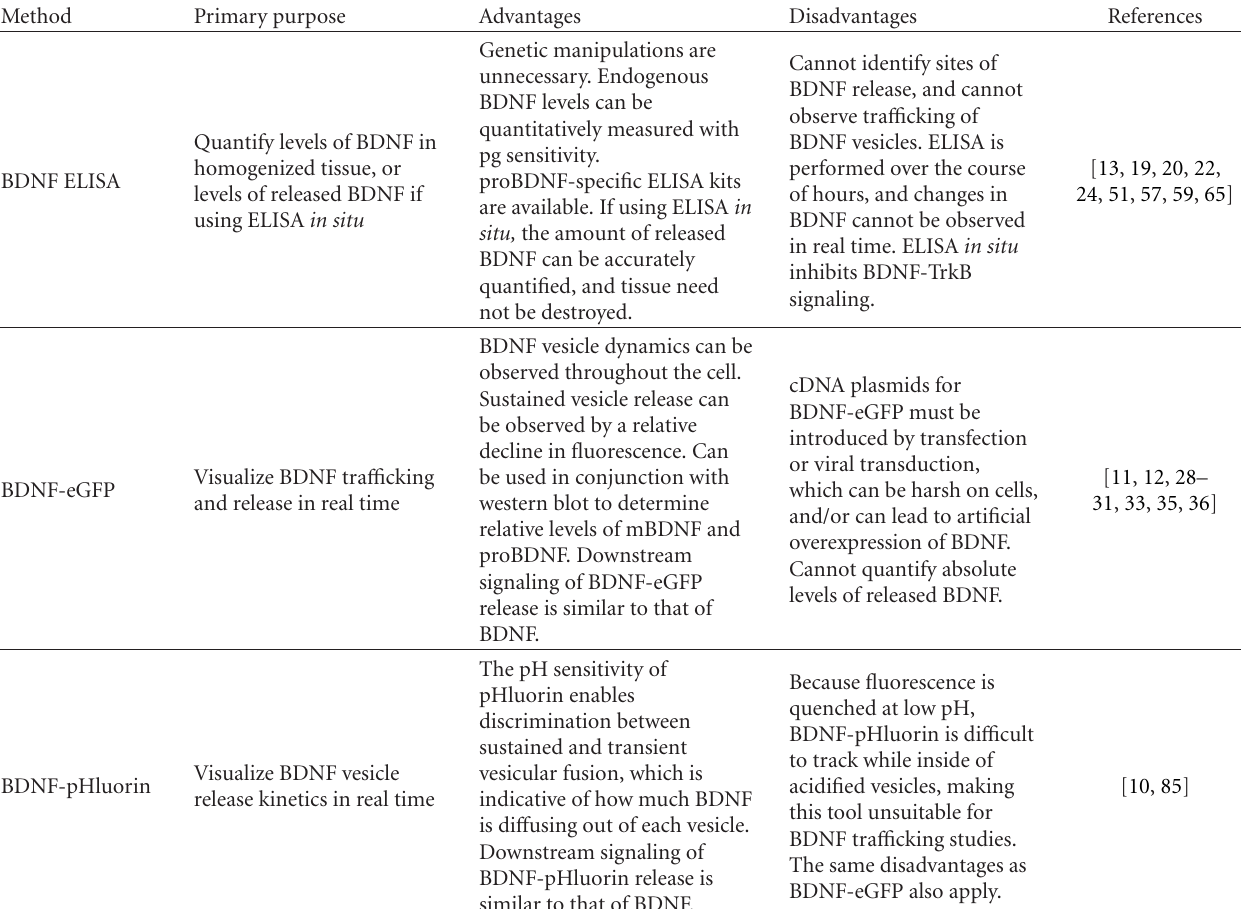
Table 1: Summary of advantages and disadvantages of using BDNF ELISA, BDNF-eGFP, BDNF-pHluorin.